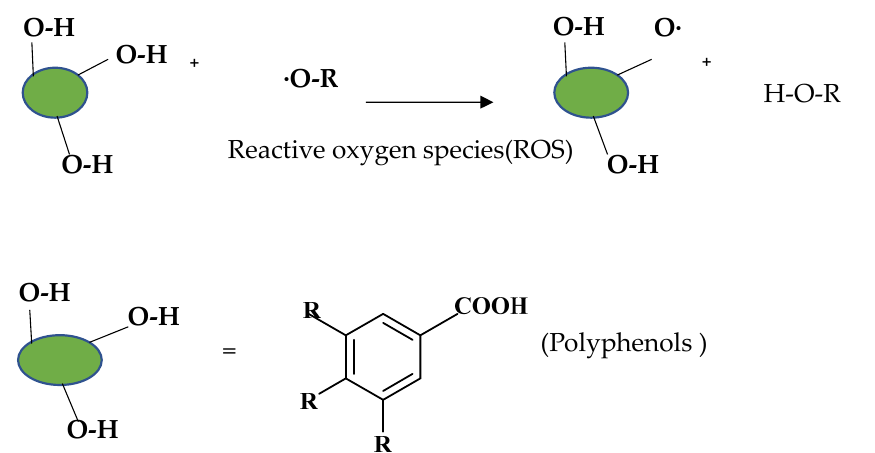
Figure 5. Removal of hydrogen, extinction of ROS, and formation of stabilized polyphenol radicals.